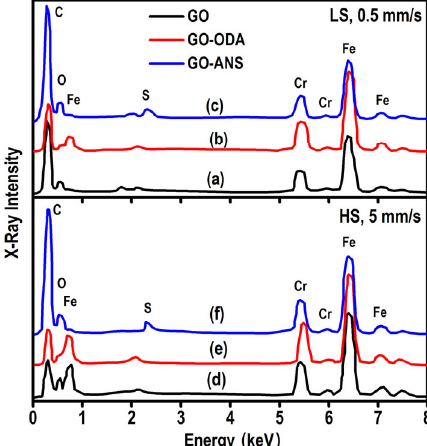
Fig. 11 Post microtribological EDS spectra of the worn disc track generated for LS ball loading dry sliding tests with (a) GO, (b) GO-ODA, (c) GO-ANS and for HS condition with (d) GO, (e) GO-ODA, (f) GO-ANS. Table 1 Elemental wt% from EDS analysis in tribo track surfaces from micro tribological ball loading tests for graphite, GO, GO-ODA and GO-ANS in both LS and HS ambient condition. Graphite GO GO-ODA GO-ANS